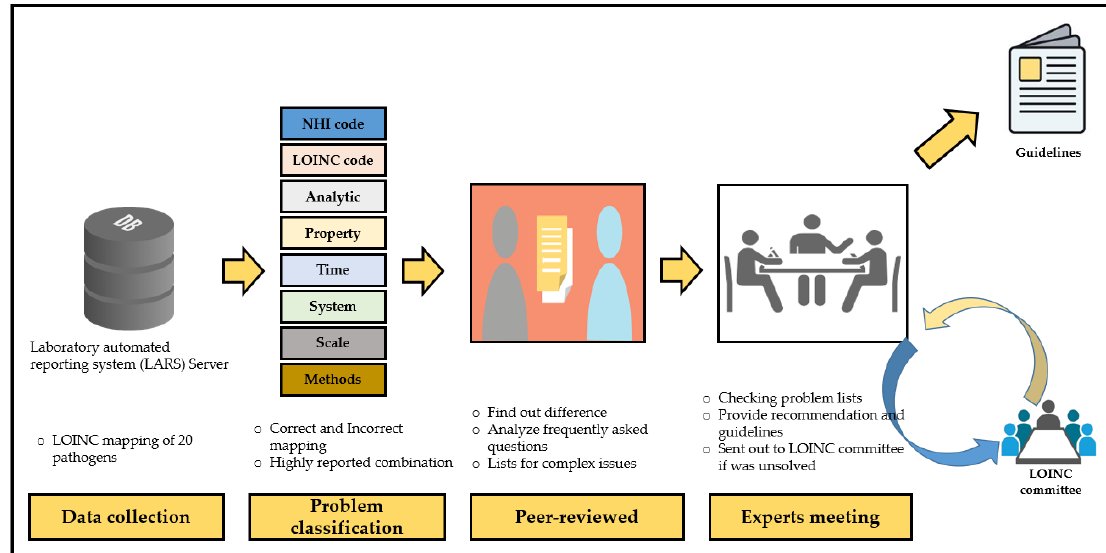
Figure 3. The entire process of the NNDSS project.